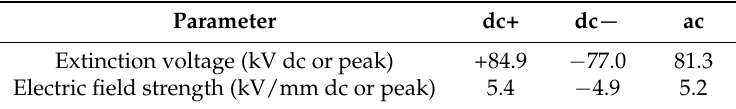
Table 5. Visual corona extinction for the substation